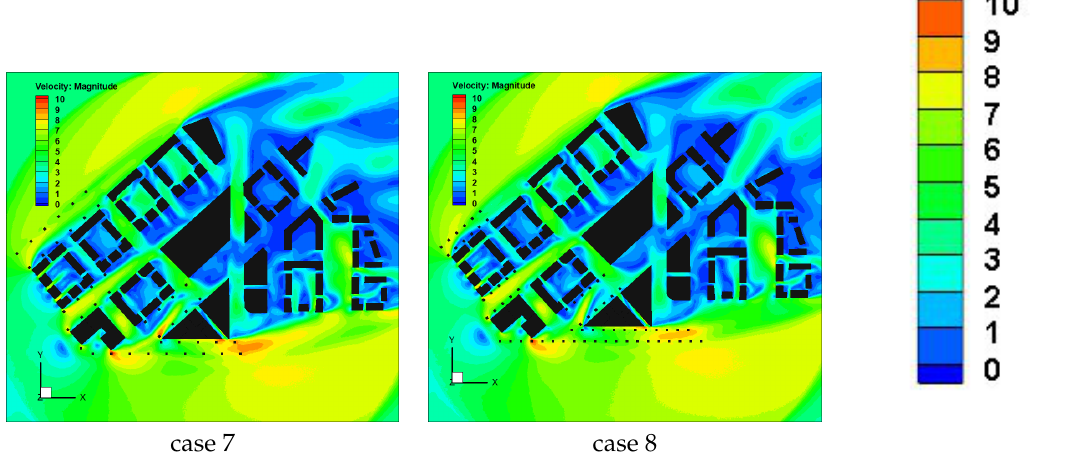
Figure 10. Velocity contours at the pedestrian level (2 m) with various tree arrangements: ( case 1 ) tree height: 12 m, minimum distance to buildings: 2/3H, distance to other trees: 2H, ( case 2 ) tree height: 12 m, minimum distance to buildings: H/2, distance to other trees: H, ( case 3 ) tree height: 12 m, minimum distance to buildings: H/2, distance to other trees: 2H, ( case 4 ) tree height: 12 m, minimum distance to buildings: H/4, distance to other trees: H, ( case 5 ) tree height: 15 m, minimum distance to buildings: H/2, distance to other trees: 2H, ( case 6 ) tree height: 15 m, minimum distance to buildings: H/2, distance to other trees: H, ( case 7 ) tree height: 15 m, minimum distance to buildings: H/4, distance to other trees: 2H, ( case 8 ) tree height: 15 m, minimum distance to buildings: H/4, distance to other trees: